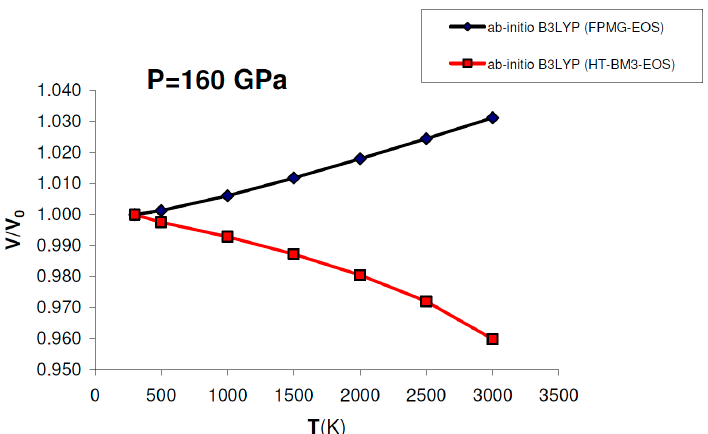
Figure 9. Ab initio B3LYP relative volume thermal expansion (V/V 0 ) of MgO calculated at P = 160 GPa by: ( a ) FPMG-EOS (blue) or ( b ) HT-BM3-EOS (red). While the former gives a V/V 0 = f (T) function with a positive slope (i.e., positive thermal expansion) at P = 160 GPa, the latter gives an anomalous negative thermal expansion in the whole T-range at the same pressure (see text for discussion).